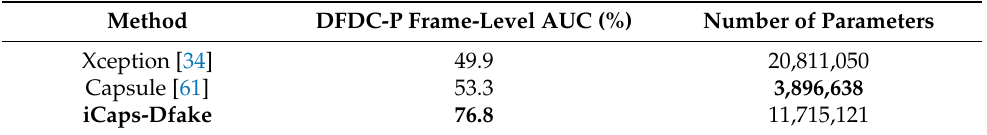
Table 8. Number of parameters